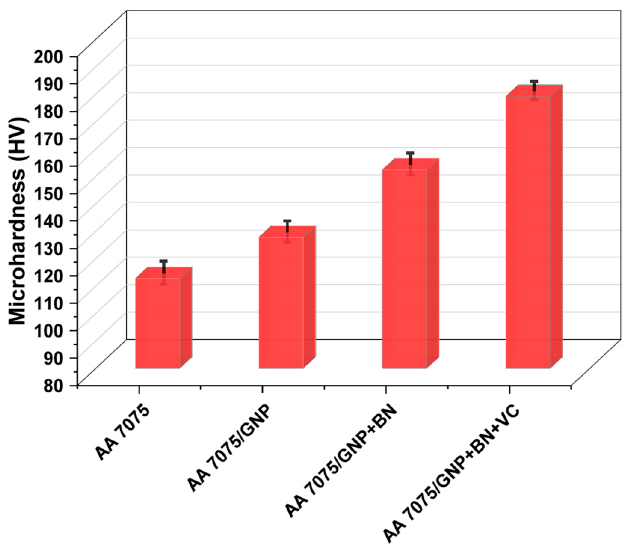
Figure 8. Microhardness profile of the investigated samples through stirred zone (SZ), heat-affected zone (HAZ), and base metal (BM).